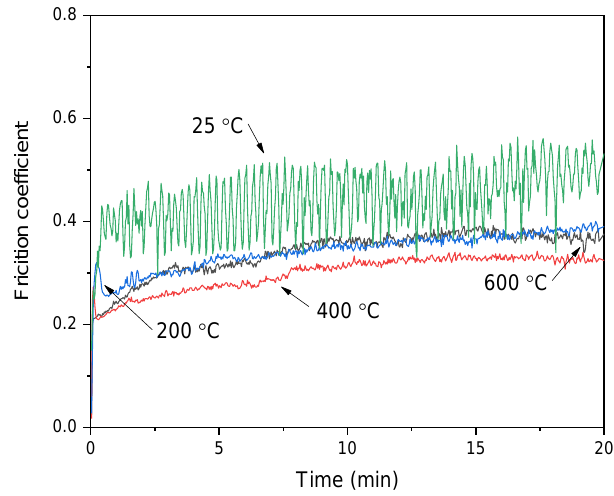
Figure 1. Variation curves of friction coefficient of Ni 3 Si alloy with 10% Ti addition against Si 3 N 4 at a load of 10 N and sliding speed of 0.10 m/s.